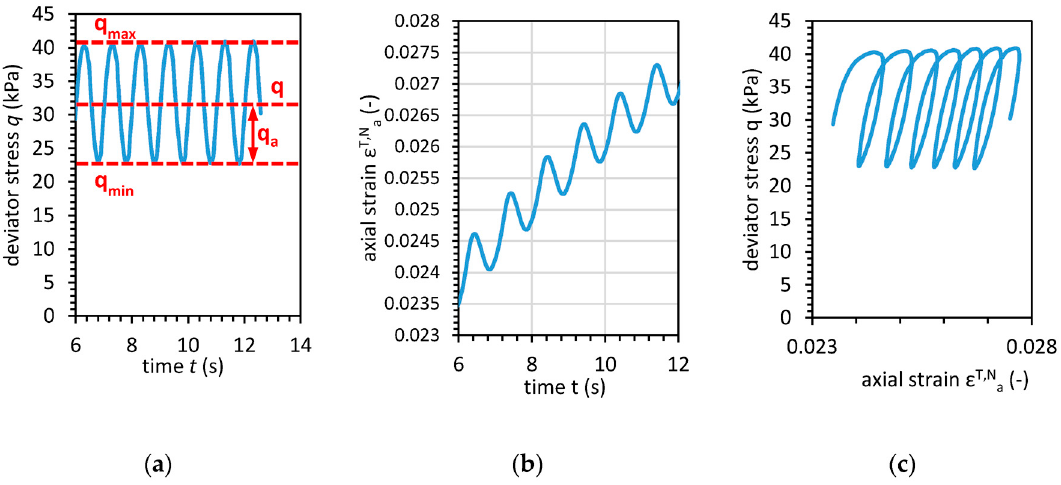
Figure 3. The load conditions of cohesive material during the cyclic triaxial test. ( a ) Deviator stress-time relationship; ( b ) Axial strain-time relationship; ( c ) Deviator stress-axial strain